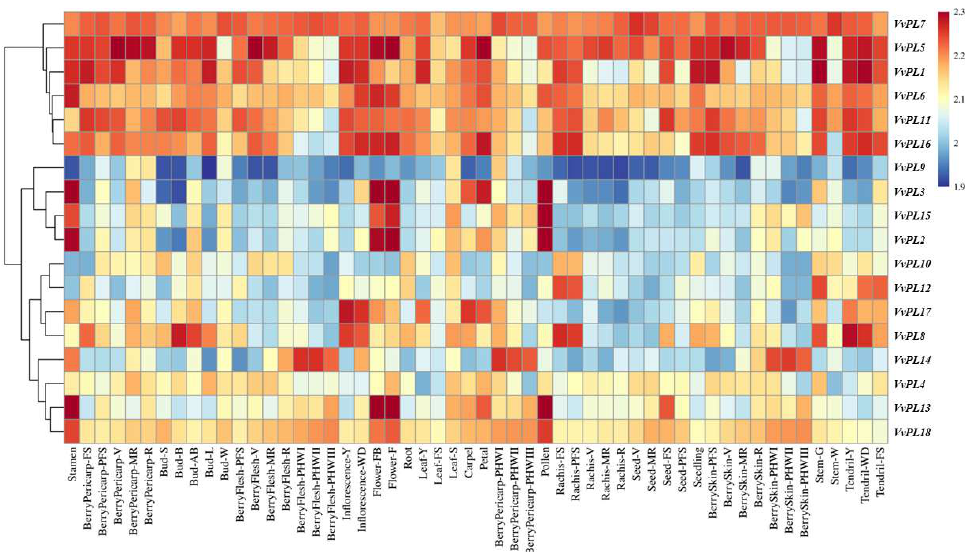
Figure 4. Tissue-specific expression patterns of VvPLs . The color scale on the right represents the RPKM normalized log 2 +1. Blue indicates low expression levels, yellow indicates moderate expression levels, and red indicates high expression levels. Transcriptome data were from the NCBI database (GSE36128) and represent multiple studies. The tissue samples were as follows: Stamen-pool of stamens from 10% and 50% open flowers; BerryPericarp-FS-berry pericarp at fruit set; BerryPericarp-PFS-berry pericarp post-fruit set; BerryPericarp-V-berry pericarp véraison; BerryPericarp-MR-berry pericarp mid-ripening; BerryPericarp-R-berry pericarp ripening; Bud-S-bud swell; Bud-B-bud burst; Bud-AB-bud after-burst; Bud-L-latent bud; Bud-W-winter bud; BerryFlesh-PFS-berry flesh